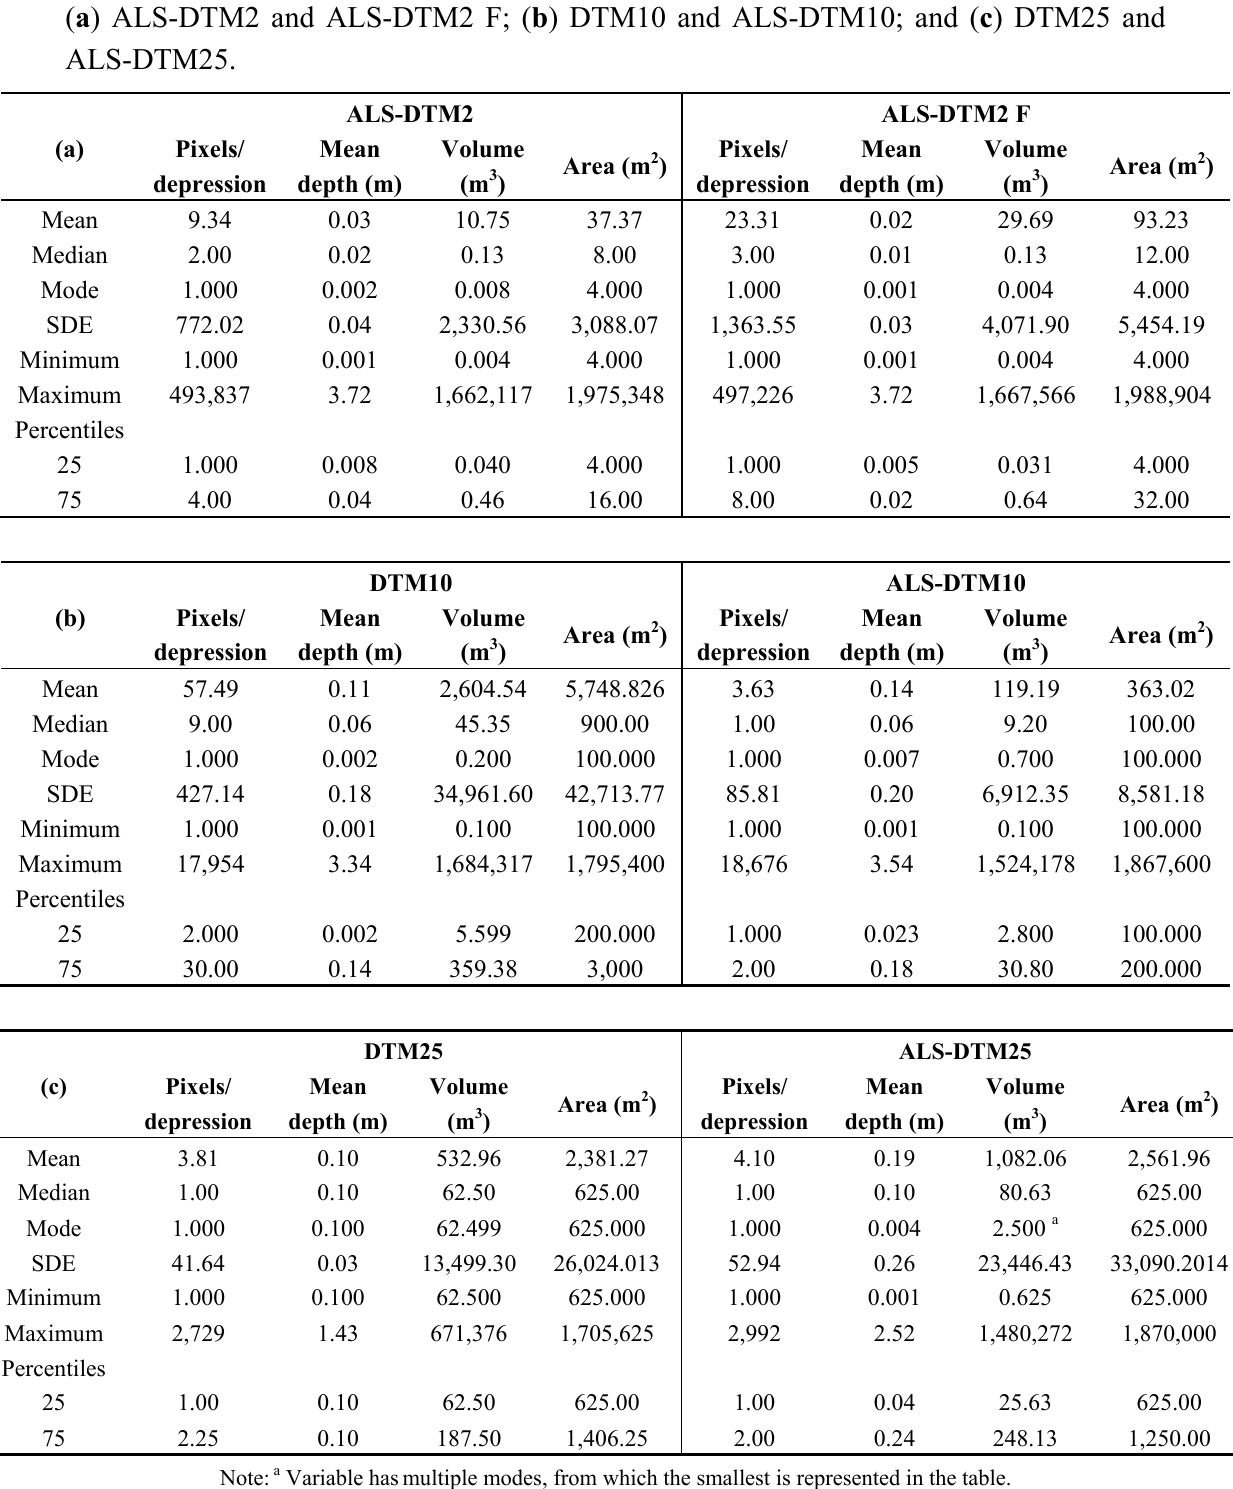
Table 6. Statistical variables of all depressions in the Lehmäjoki River